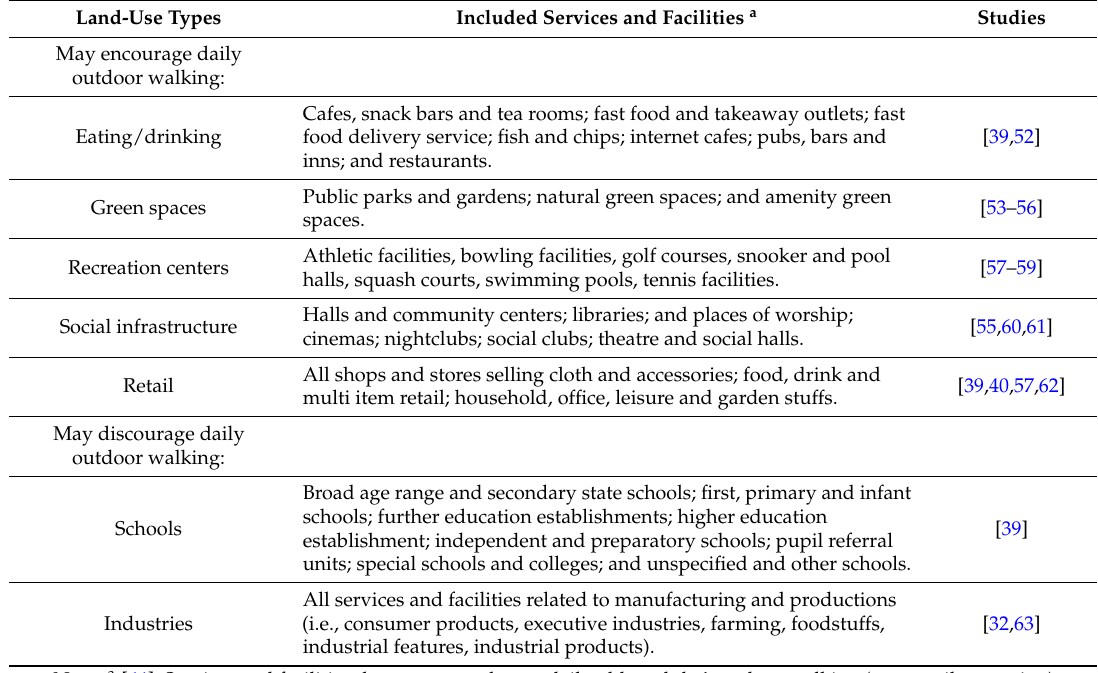
Table 3. Description of non-residential land-use